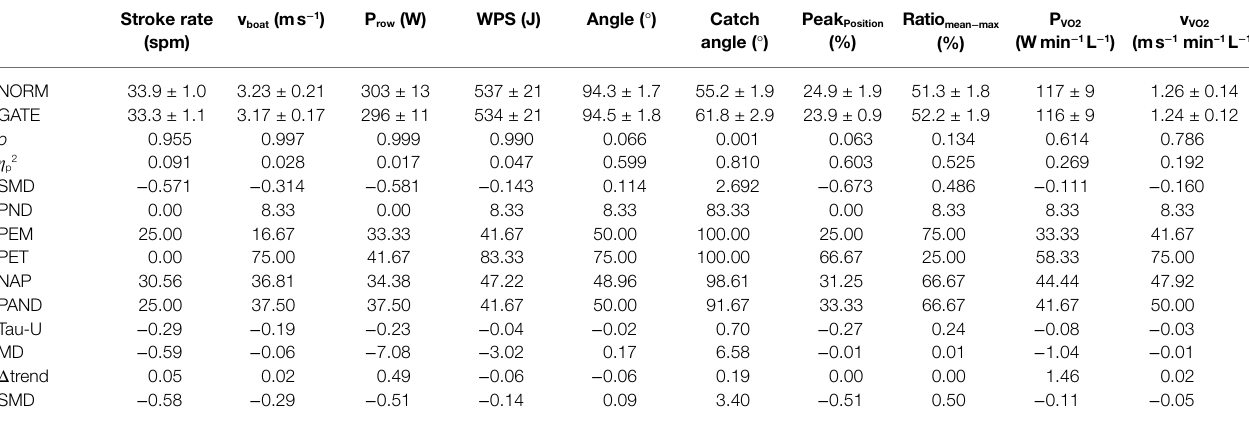
TABLE 2 | Output parameter and overlapping indices of the single case repeated measurements (in-field rowing measurements). Stroke rate